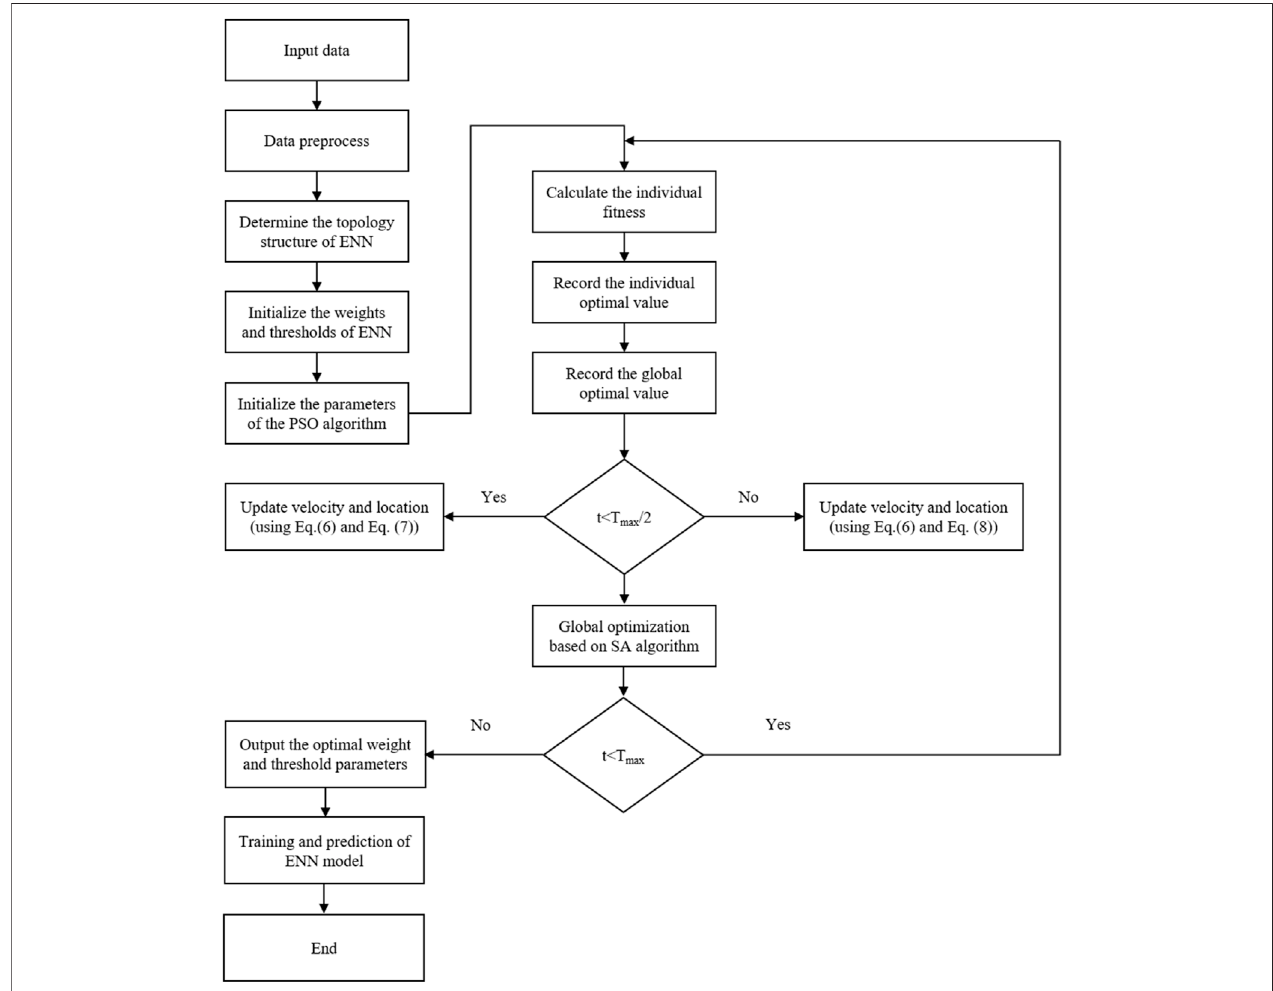
FIGURE 4 | Flowchart diagram of the proposed ASAPSO-ENN